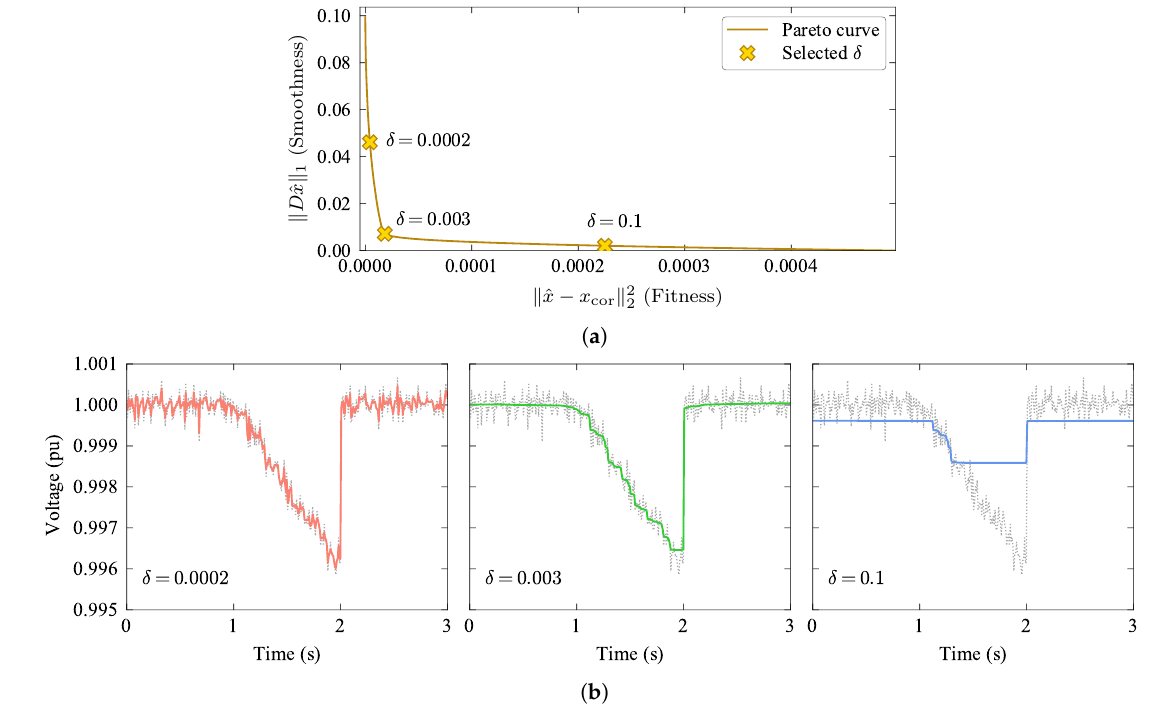
Figure 10. Results of filtering the corrupted synthetic signal 2 through total variation smoothing. ( a ) Pareto curve. ( b ) Estimated signals representing under-filtering ( δ = 0.0002), optimal filtering ( δ = 0.003) and over-filtering ( δ = 0.1).